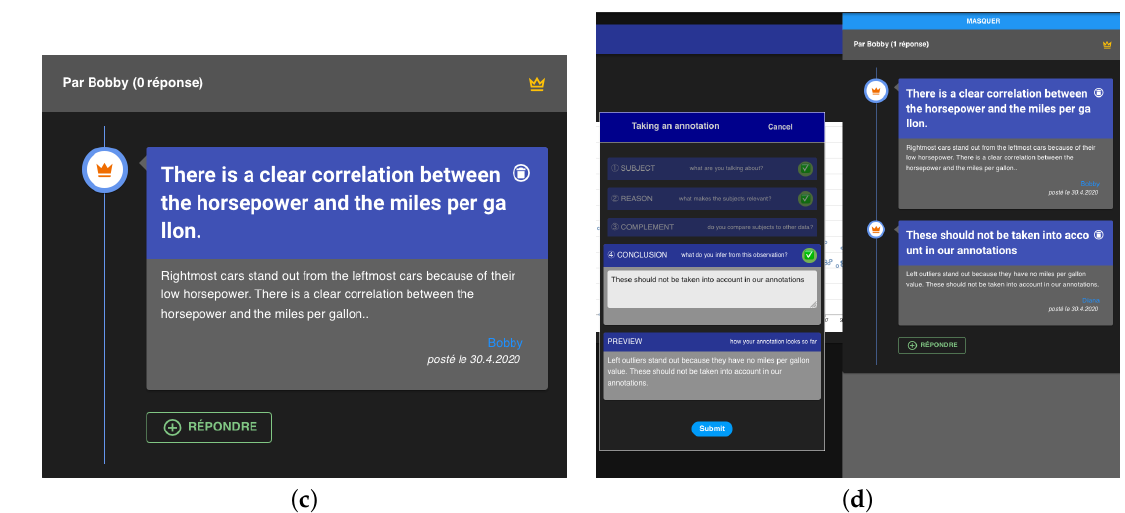
Figure 6. Example visualizations to illustrate the usage of Vasco and the interface. ( a ) Bobby creates a new visualization out of a dataset. ( b ) Bobby then annotates his dataset. ( c ) The annotation is displayed in a drawer as a text. ( d ) Diana leaves a reply on the same dataset, with a different visualization, by clicking the “Répondre” (“Reply”, in French)